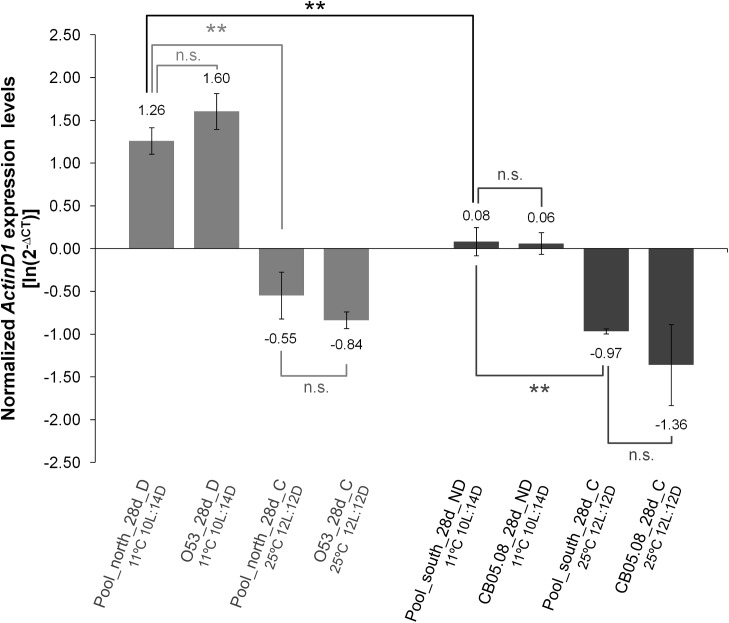
The pattern of ActinD1 expression is not specific of the genetic background of the two strains used in this work.
ActinD1 gene expression levels of pools of 28 days old diapausing females from nine strains from the north of the distribution showing over 90% of diapause incidence and pools of 28 days old control flies reared under non-diapause inducing conditions were compared with the expression levels obtained for O53 diapausing females and controls. The expression levels of ActinD1 were also obtained for pools of 28 days old non-diapausing females from nine strains from the south of the distribution showing less than 15% of diapause incidence and pools of 28 days old control flies reared under non-diapause inducing conditions and then they were compared with the expression levels obtained for CB05.08 non-diapausing females and controls. The reference gene RpL32 was used to normalize the expression values. Three biological replicates were used for each sample and the averages of the log-transformed values of 2-∆CT are presented with their respective S.E.M. A two-tailed Student’s t test assuming equal variances was used to address if the averages of normalized ActinD1 expression levels of the different samples and treatments are significantly different (n.s. P > 0.05; ** 0.01 > P > 0.001).